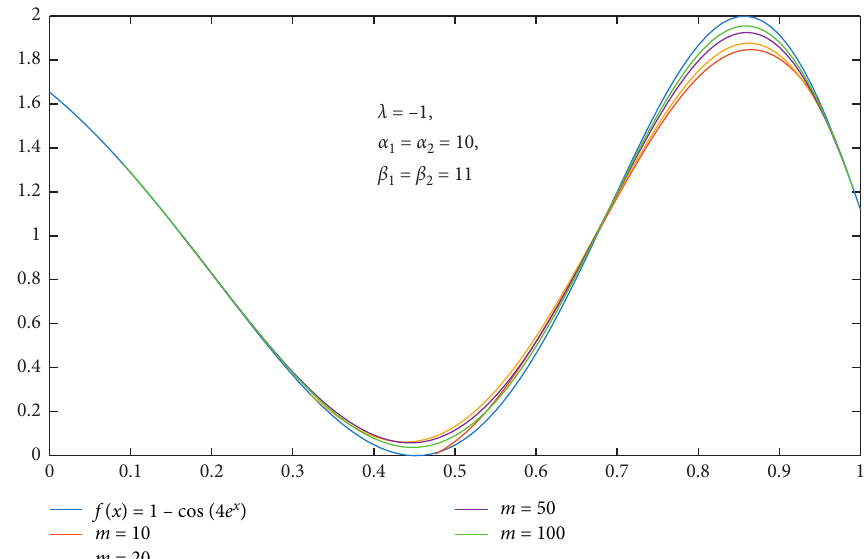
Figure 3: Convergence of G 10 , 11